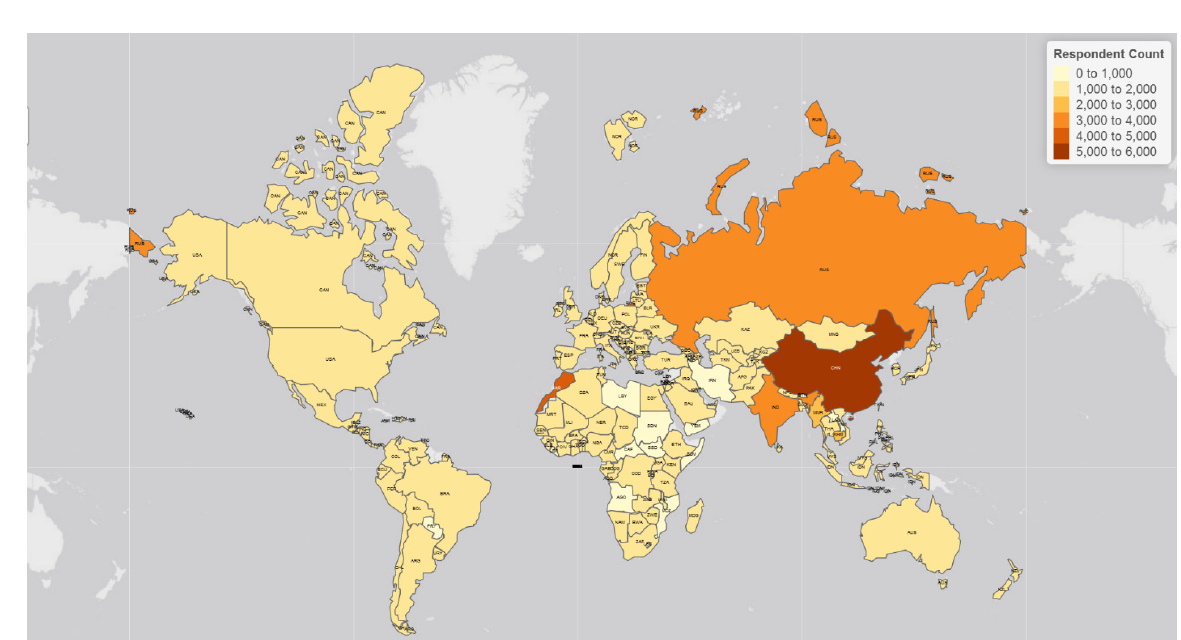
Figure A1. Global map of respondents’ absolute frequency count by country in the pooled sample (2014 and 2017). Source: Author’s own construction using the global financial inclusion surveys (2014 and 2017). (See dynamic web link at https://rpubs.com/brassbe1982/respondentCount_figb1 (accessed on 21 December 2021)).